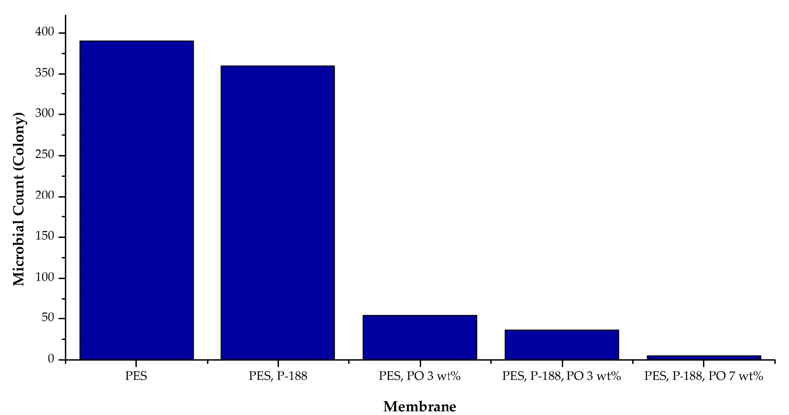
Figure 6. The count of E. coli during the antibacterial activity test.